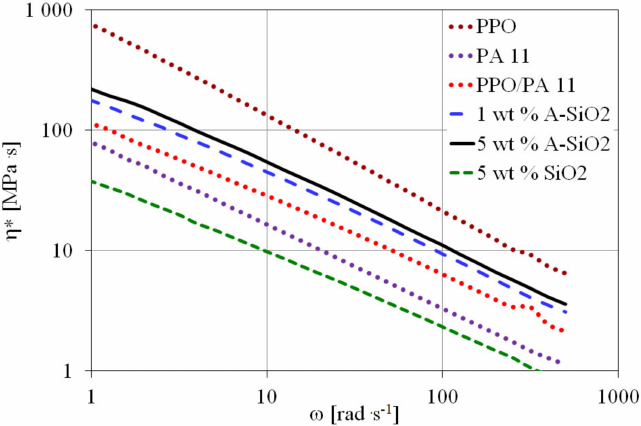
Figure 7. Complex viscosity versus frequency for PPO, PA11, and PPO/PA11/silica composites differing in silica type and loading at 270 ◦